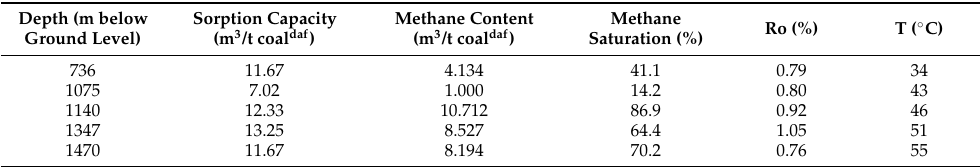
Table 2. Sorption capacities, measured methane contents, vitrinite reflectance (Ro) and rock tempera- tures (T) in ´Cwiklice and Mi˛edzyrzecze sub-areas